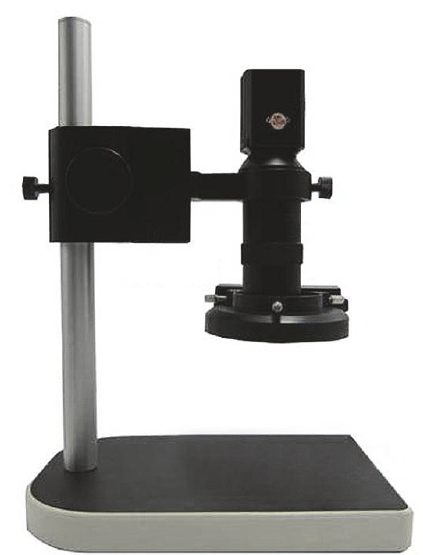
Figure 5: Universal tool